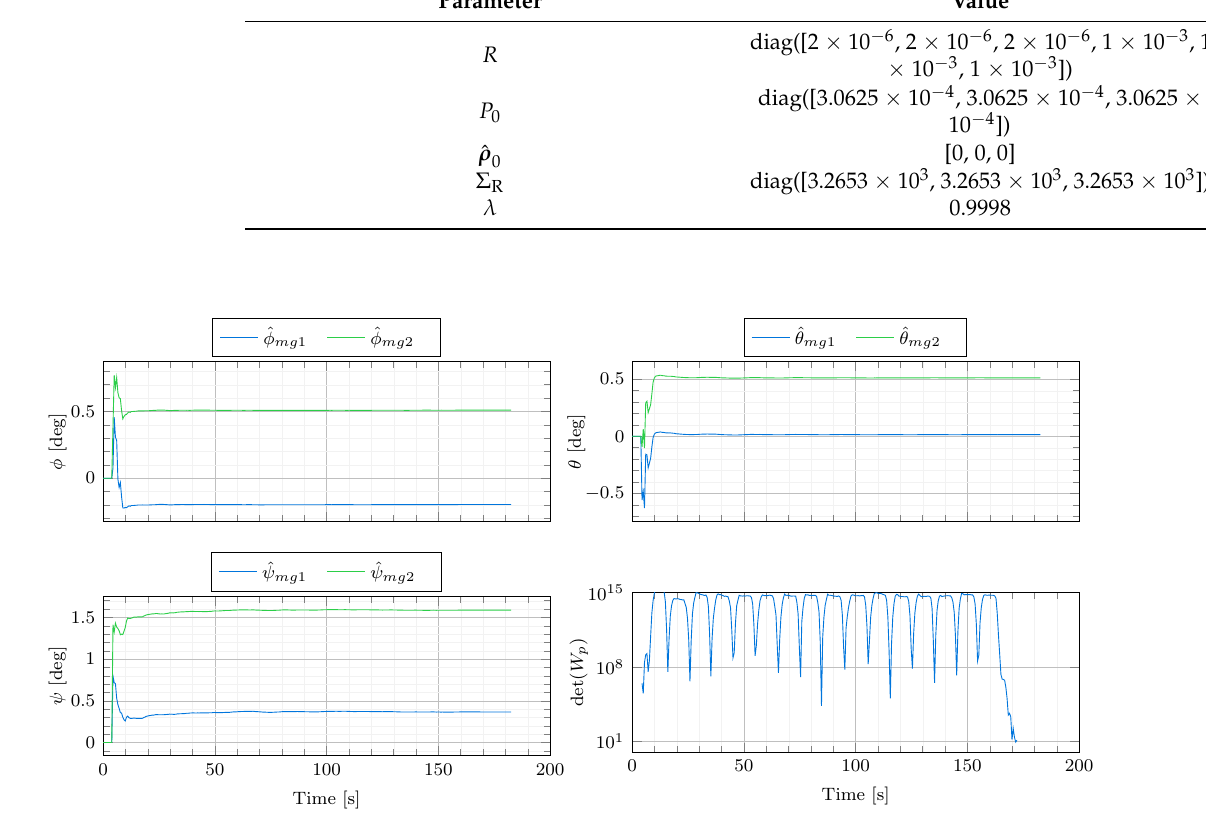
Figure 10. Estimation results for the figure eight manoeuvre of Figure 9. ˆ φ mg 1 , ˆ θ mg 1 , ˆ ψ mg 1 are the parameter estimates obtained based on the original data. ˆ φ mg 2 , ˆ θ mg 2 , ˆ ψ mg 2 are the parameter estimates obtained based on the data corrupted by the artificial misalignment error ( 0.7,0.5,1.2 ) deg for φ mg , θ mg and ψ mg , respectively. Finally, the determinant of the excitation matrix W p = H k H T is depicted in the last k